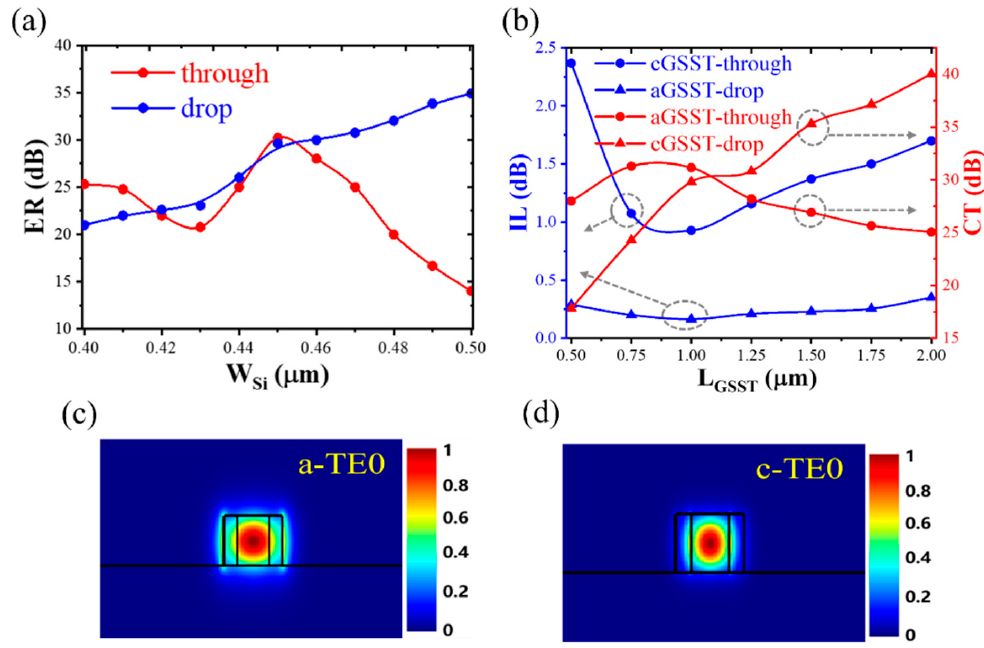
Figure 3. ( a ) ER versus the waveguide width. ( b ) IL and CT versus GSST length. TE0 mode distributions in the ( c ) amorphous and ( d ) crystalline states.